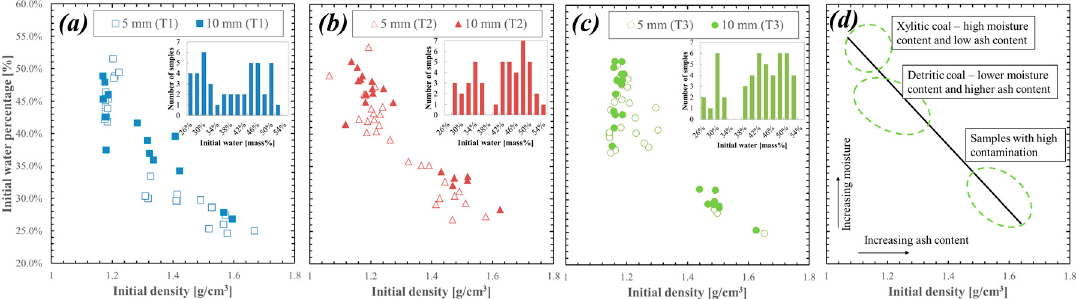
Figure 14. Correlation between the WP ini (mass%) and the density of samples at the initial state for Samples: ( a ) T1; ( b ) T2; ( c ) T3; and ( d ) correlation between ash and moisture content.